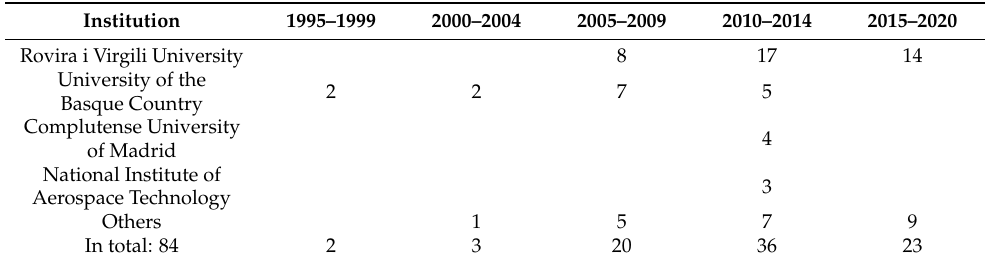
Table 3. Distribution of the papers published about rheology and thermosets in the period